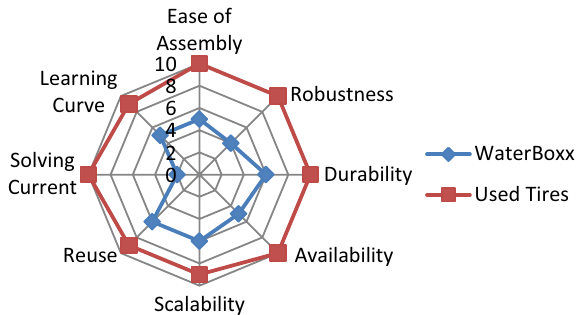
Figure 7. Quality profiles of the original design (in red) and proposed alternative design (in blue).